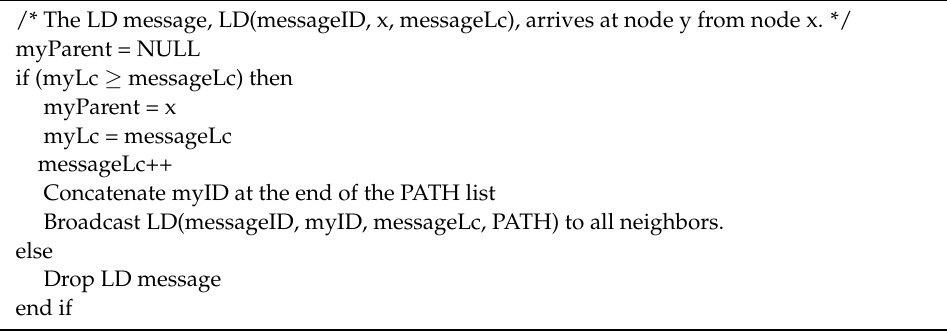
Algorithm 2 : BD at an intermediate node. Reception of an LD